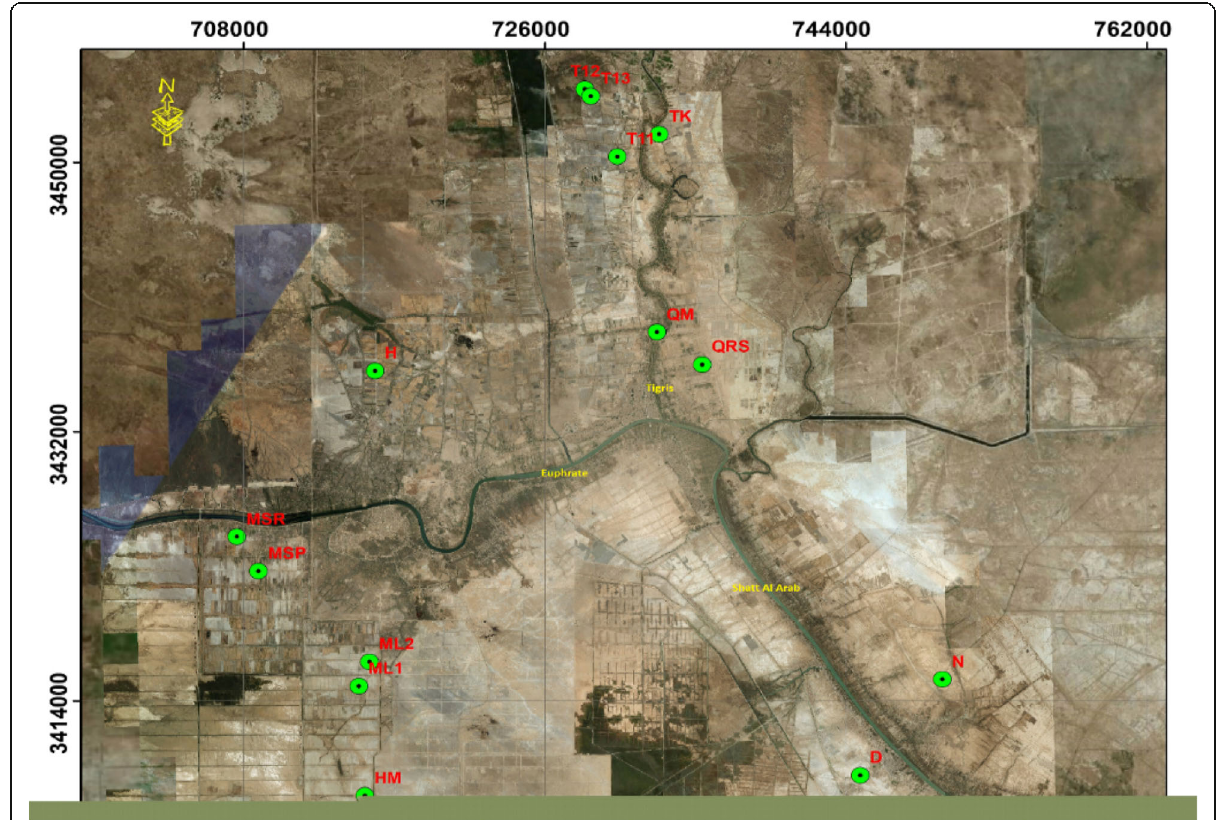
Fig. 1 Map of the south of Basra illustrating the 14 selected wheat fields where symptomatic wheat plants were collected in 2018/2019